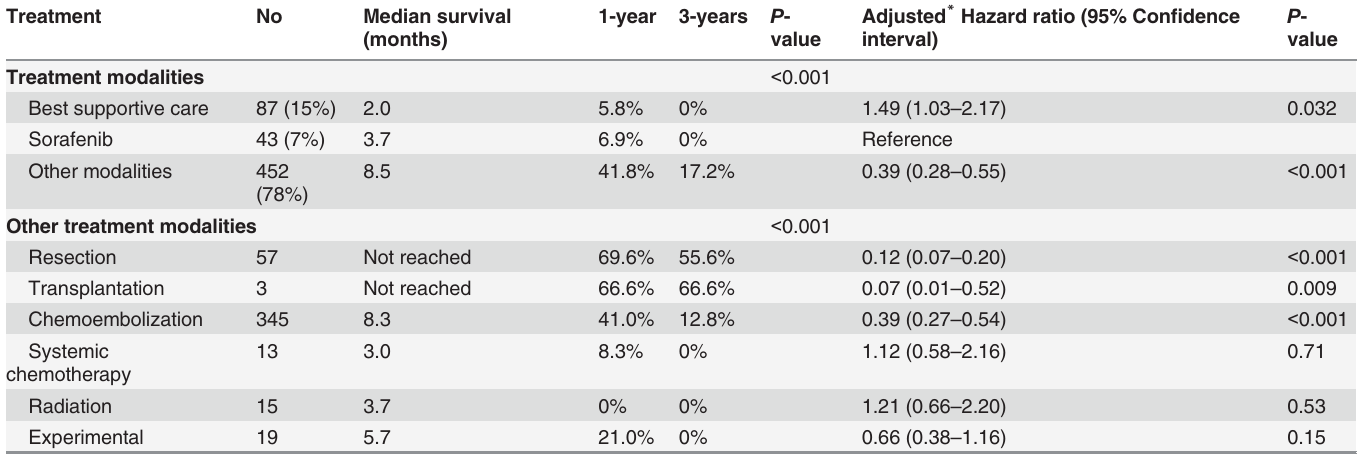
Table 4. Survival by treatment modalities.